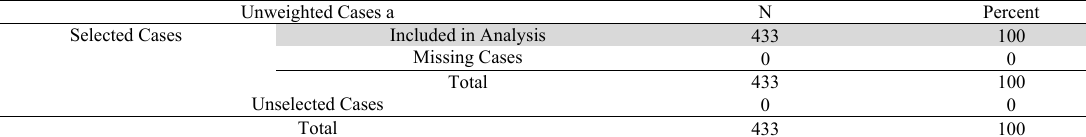
Dependent Variable Encoding